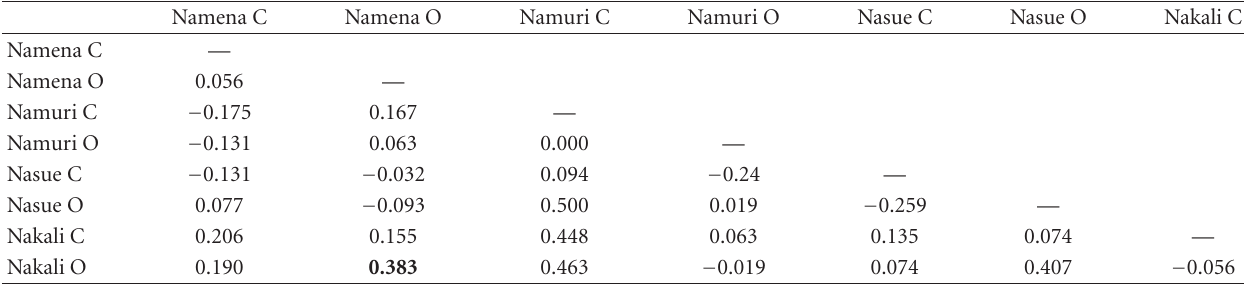
Table 4: R values from pairwise comparisons from one way ANOSIM of benthic strata across 2009 closed (C) sites within and open (O) sites adjacent to Kubulau MPAs. Significant di ff erences at P < . 05 are in